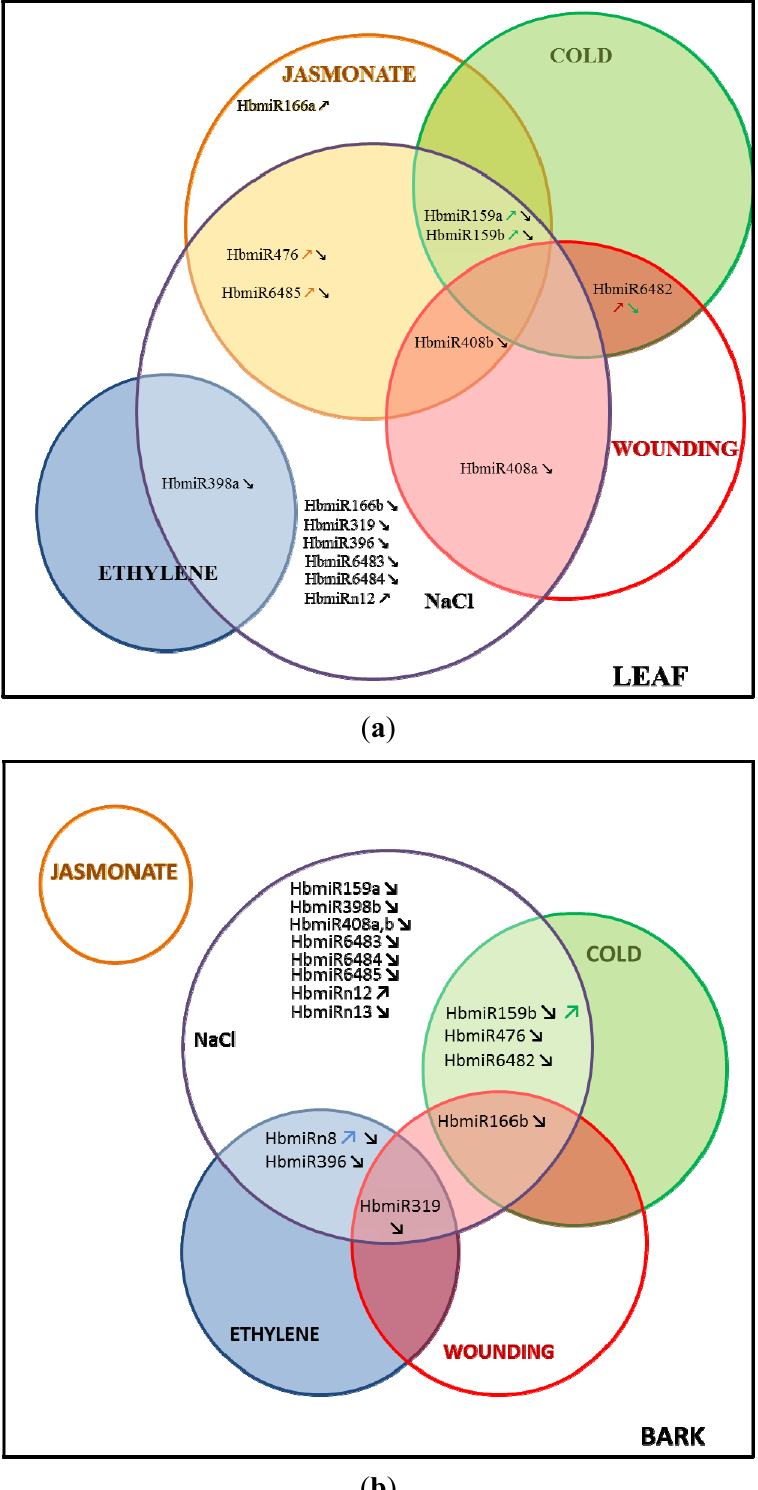
Figure 1. Venn diagram representing the regulation of the MIR genes common to all the treatments tested. ( a ): in leaves; and ( b ): in